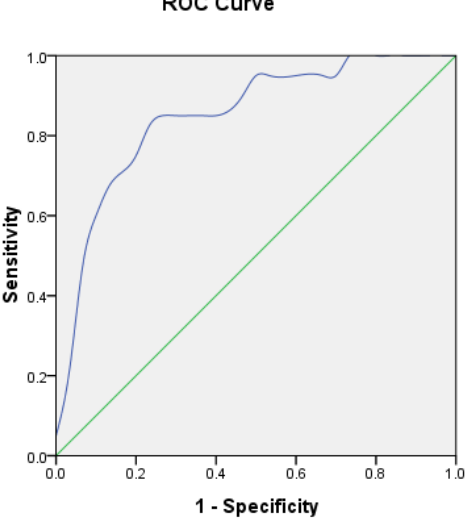
Figure 1. ROC curve calculation for the logistic regression model applied to the modeling group (n =